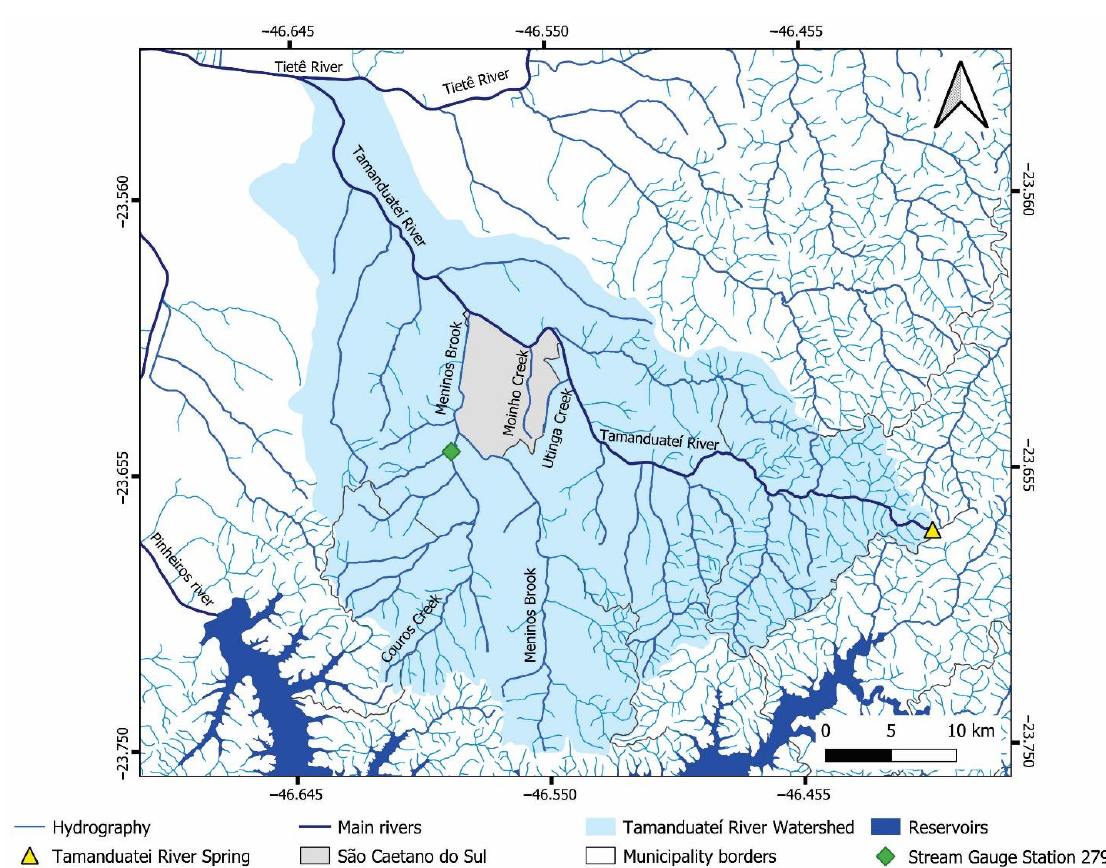
Figure 2. Tamanduateí River Watershed